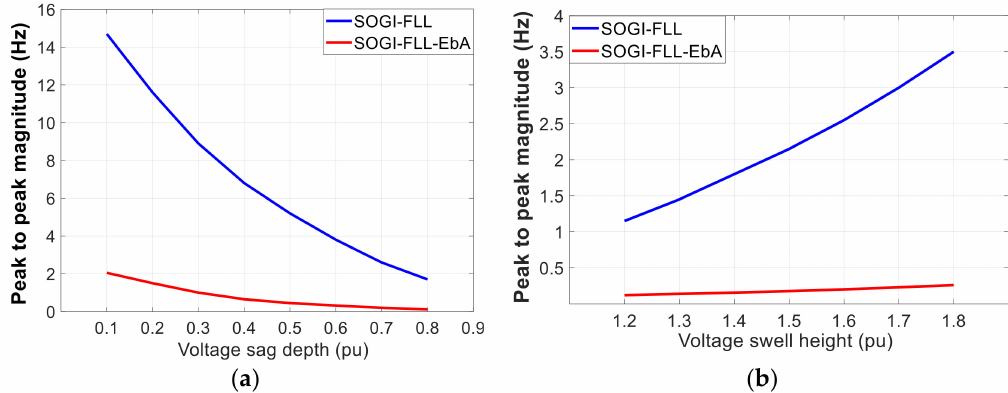
Figure 14. Measured peak-to-peak maximum amplitude distortion in Hz for different voltage sags and swells. ( a ) For sags with depths ranging from 0.1 to 0.8 pu. ( b ) For swells with heights ranging from 1.2 to 1.8